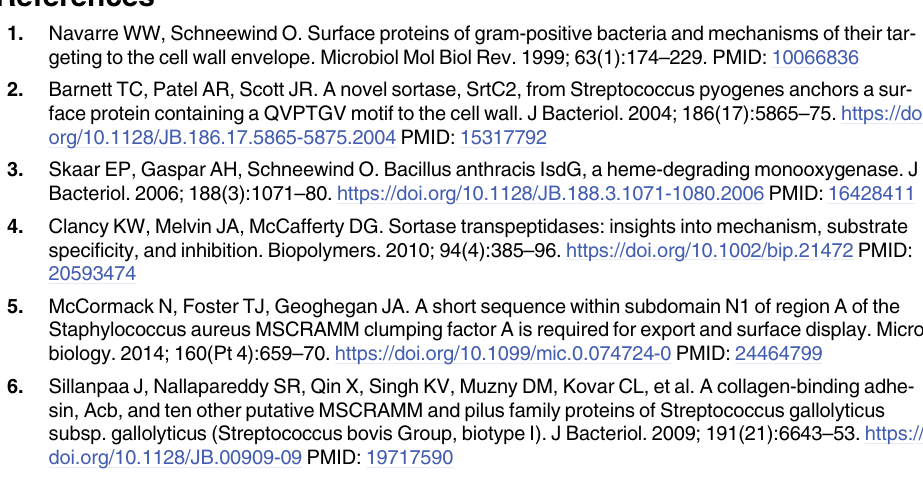
S6 Fig. Time series of the clustering analysis. a) SrtA-Ca. b) SrtA-noCa. The most populated cluster is numbered as cluster 0. (TIF) S7 Fig. Representative structures of the clusters obtained from the SrtA-Ca simulation.